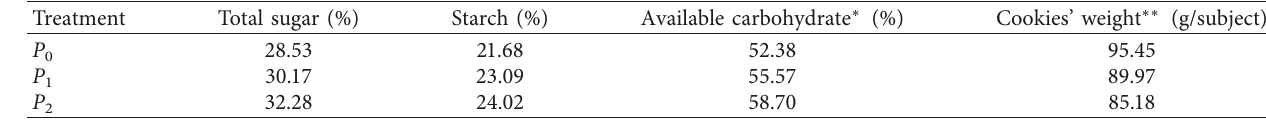
Table 3: Cookies’ weight stipulation per subject.